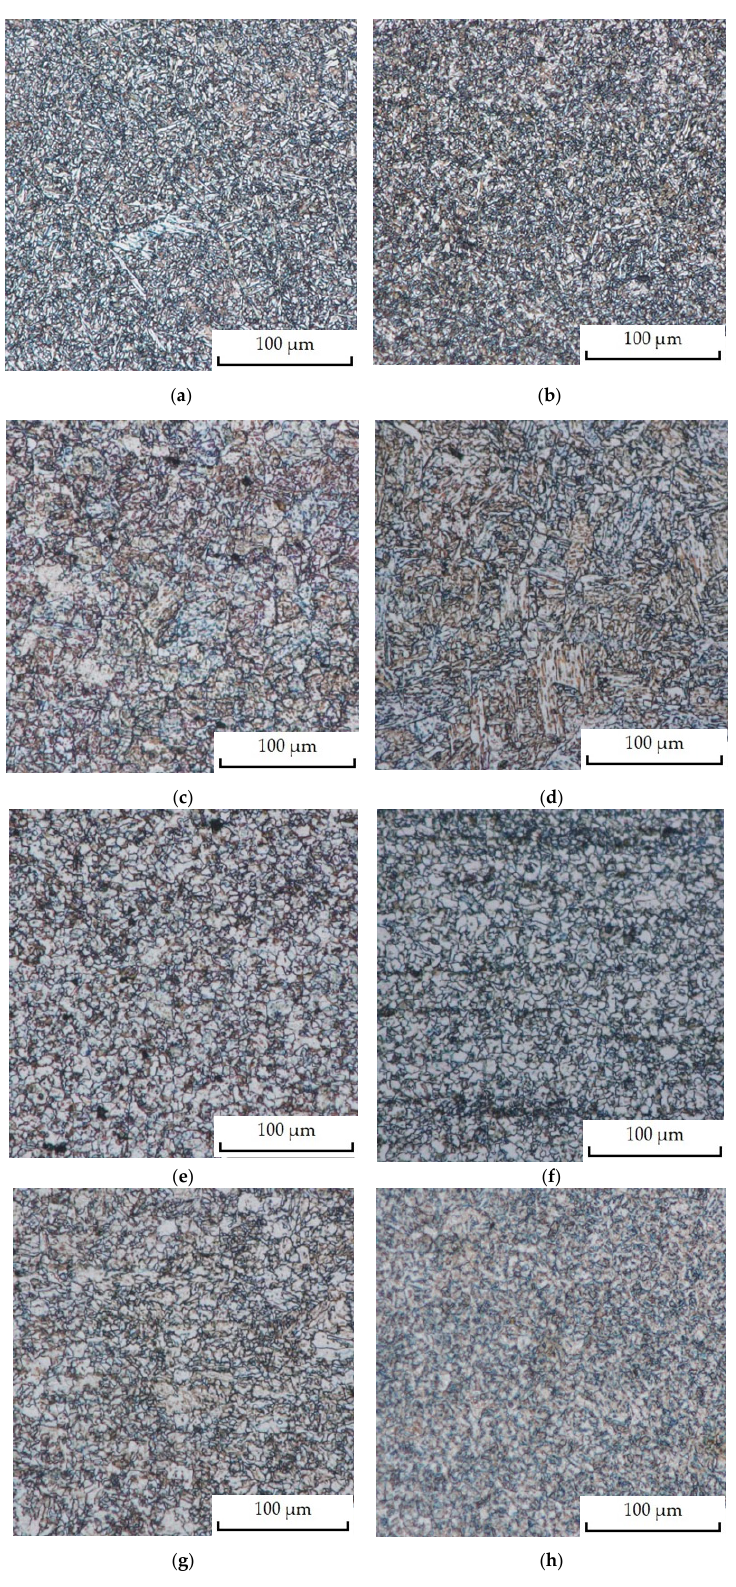
Figure 7. Metallographic structure of the weld joints: ( a ) fusion zone of 0 V; ( b ) fusion zone of 10 V; ( c ) CGHAZ of 0 V; ( d ) CGHAZ of 10 V; ( e ) GRHAZ of 0 V; ( f ) GRHAZ of 10 V; ( g ) ICHAZ of 0 V; and ( h ) ICHAZ of 10 V.